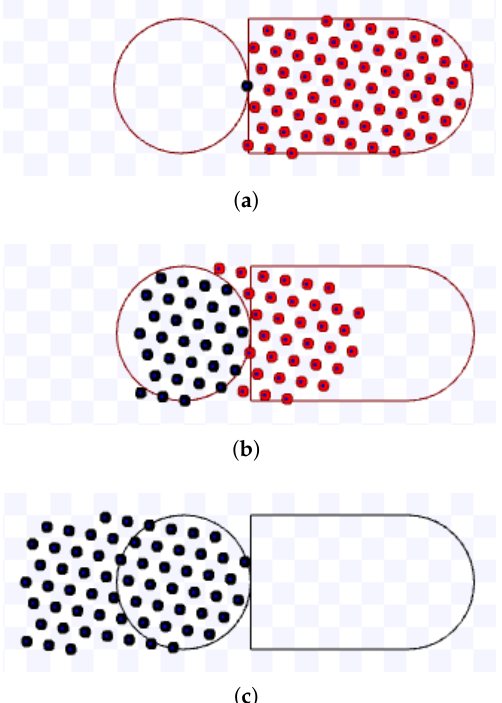
Figure 29. Simulation on Stage for hexagonal packing strategy using s = 3 m, θ = 5 π / 18 during T = 10 s. Available on https://youtu.be/jRLgaF7Te1Q, accessed on 12 June 2022. ( a ) 0 s: beginning of the simulation; ( b ) After 4.9 s; ( c ) 10 s: ending of the